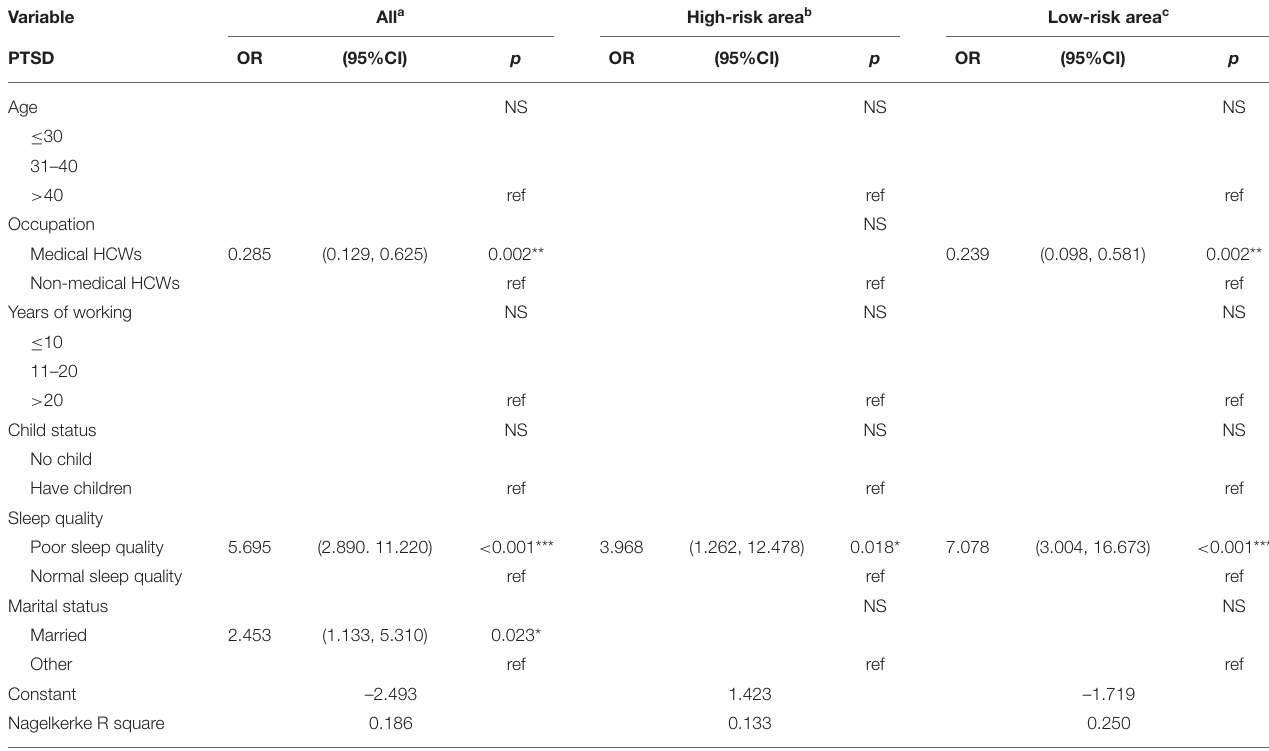
TABLE 5 | Multiple logistic regression of risk factors of PTSD symptoms.